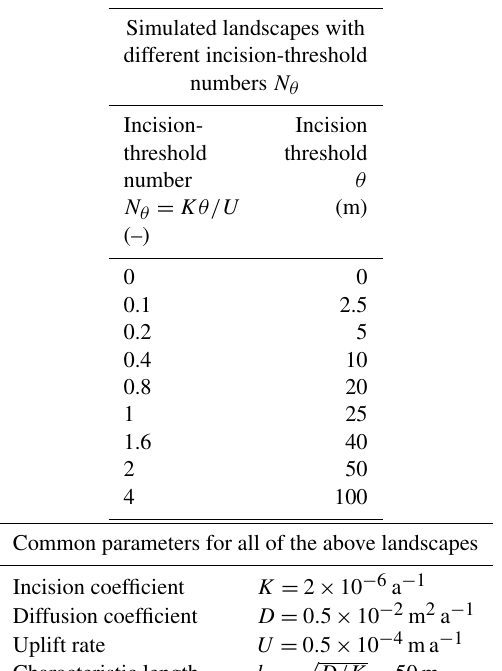
Table 4. Incision-threshold numbers N θ and corresponding incision thresholds θ , parameters K , D , and U , and characteristic scales of the landscapes described in Sect. 3.2. All nine landscapes have the same parameters K , D , and U and, thus, the same characteristic scales. These landscapes are illustrated in Figs.